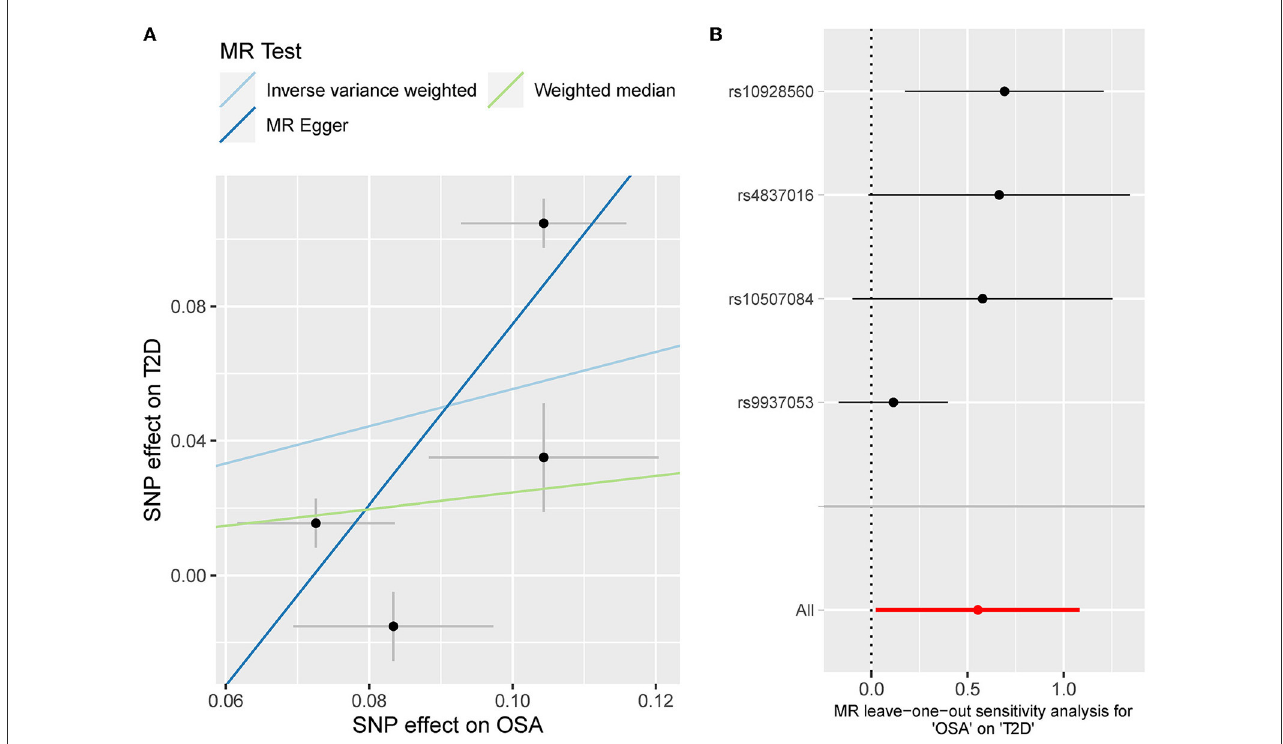
FIGURE3 (A) The scatterplot of OSA-T2D results. Different colors represent different methods and each point is a single nucleotide polymorphism. The horizontal and vertical lines of each point represent the 95% confidence interval of the effect size. (B) The leave-one-out-sensitivity forest plot of OSA-T2D